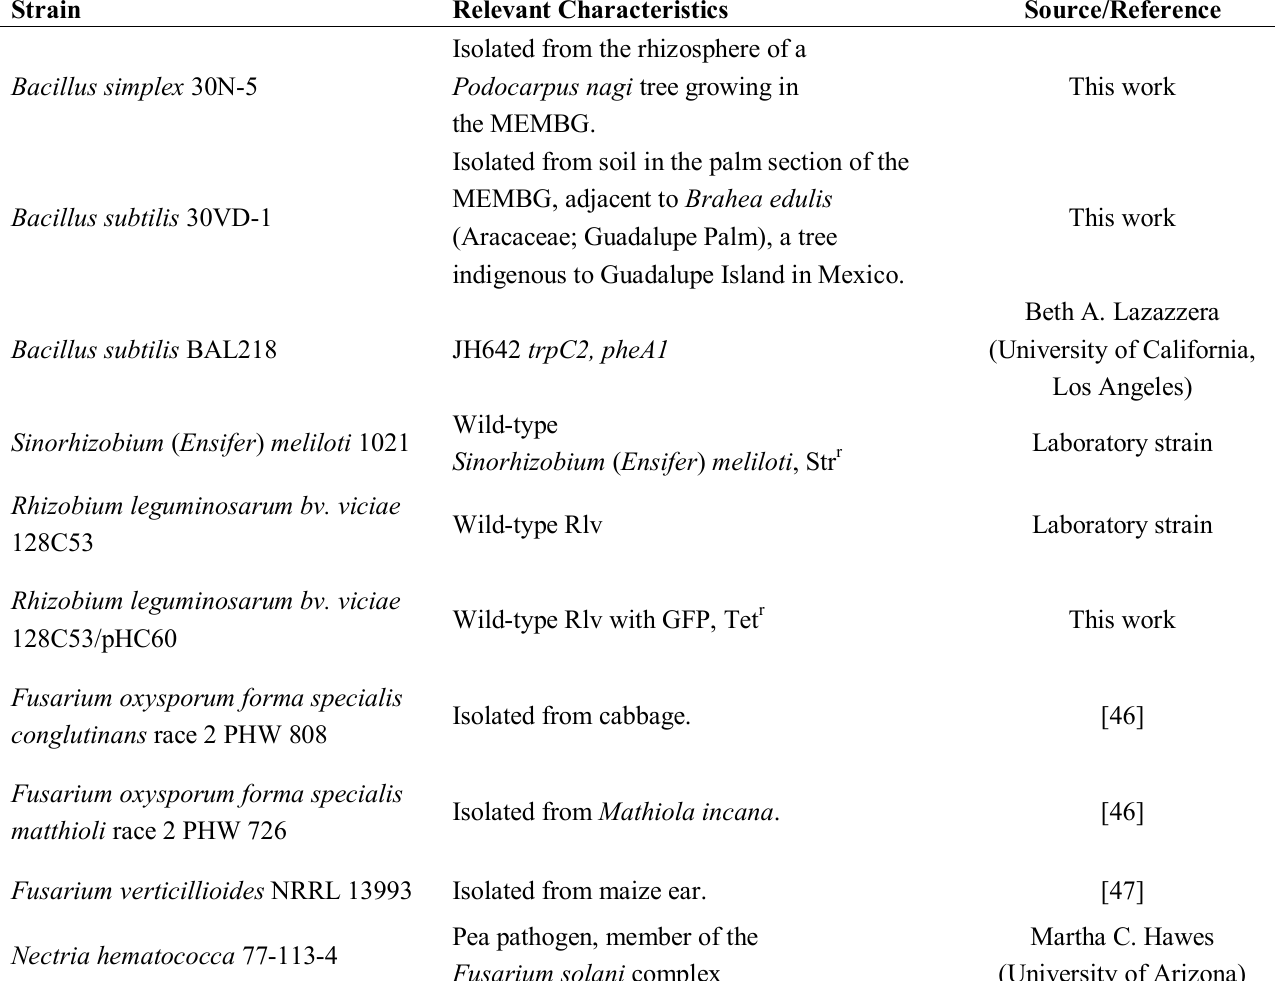
Table 1. Strains used in this